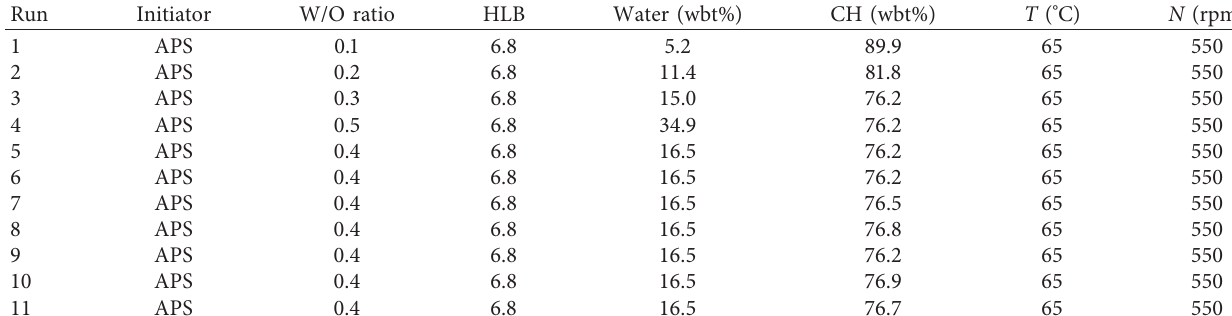
Table 2: Polymeric nanoparticle design experiment.